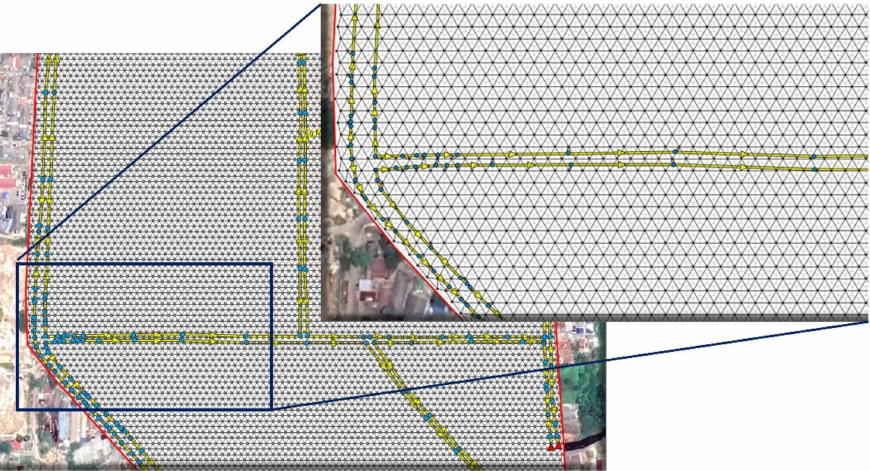
Figure 6. Direct connections between 2-D mesh (black lines) and 1-D drainage channel (yellow